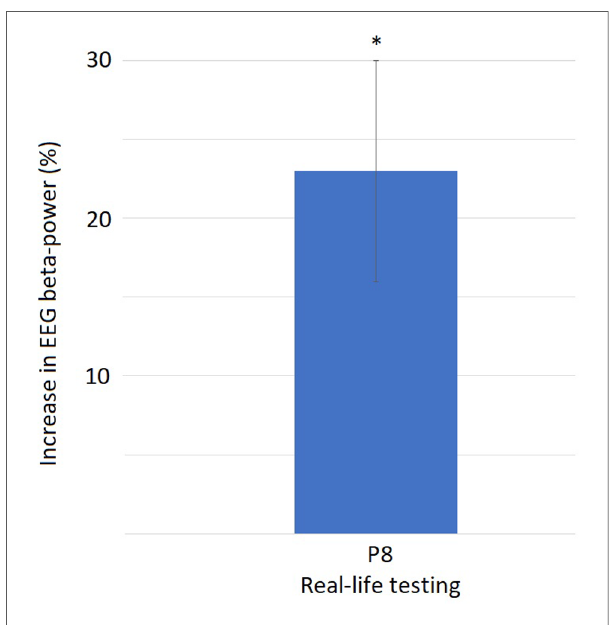
FIGURE 8 Increase of beta-band activity at electrode position P8: EEG beta-band activity at 27 Hz increases signi fi cantly by 23% [SD 7, t (6)=3.92, p =0.002] when manual interaction with the SLS is required compared to the automated